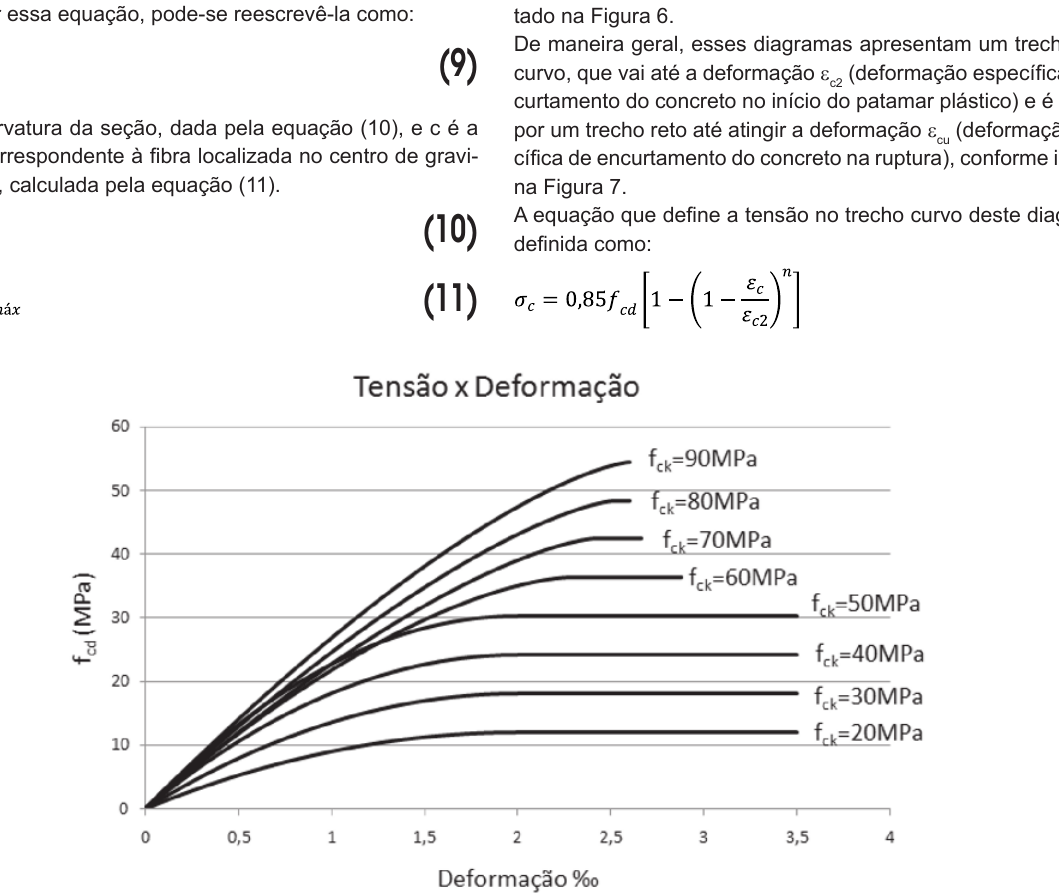
Figura 6 Diagrama tensão-deformação para concretos de C20 a